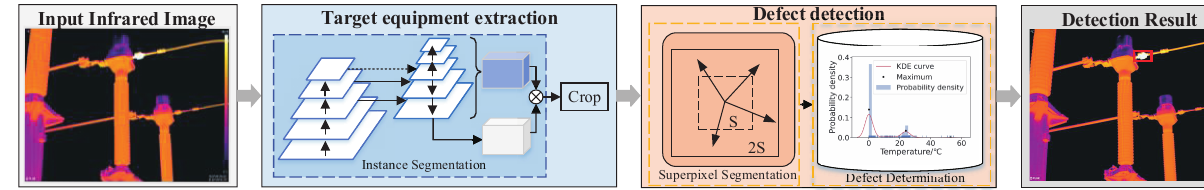
Figure 1. Flowchart of